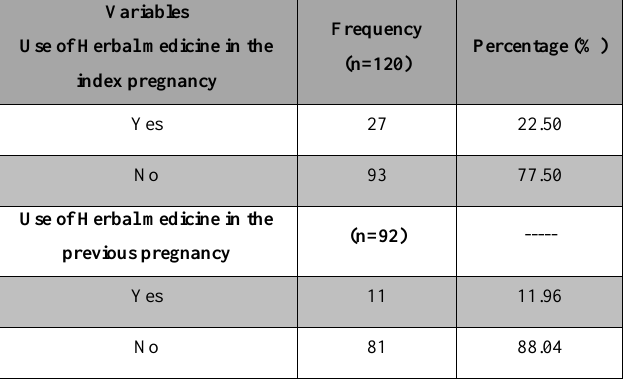
Table 2. Use of Herbal medication among the study subjects.